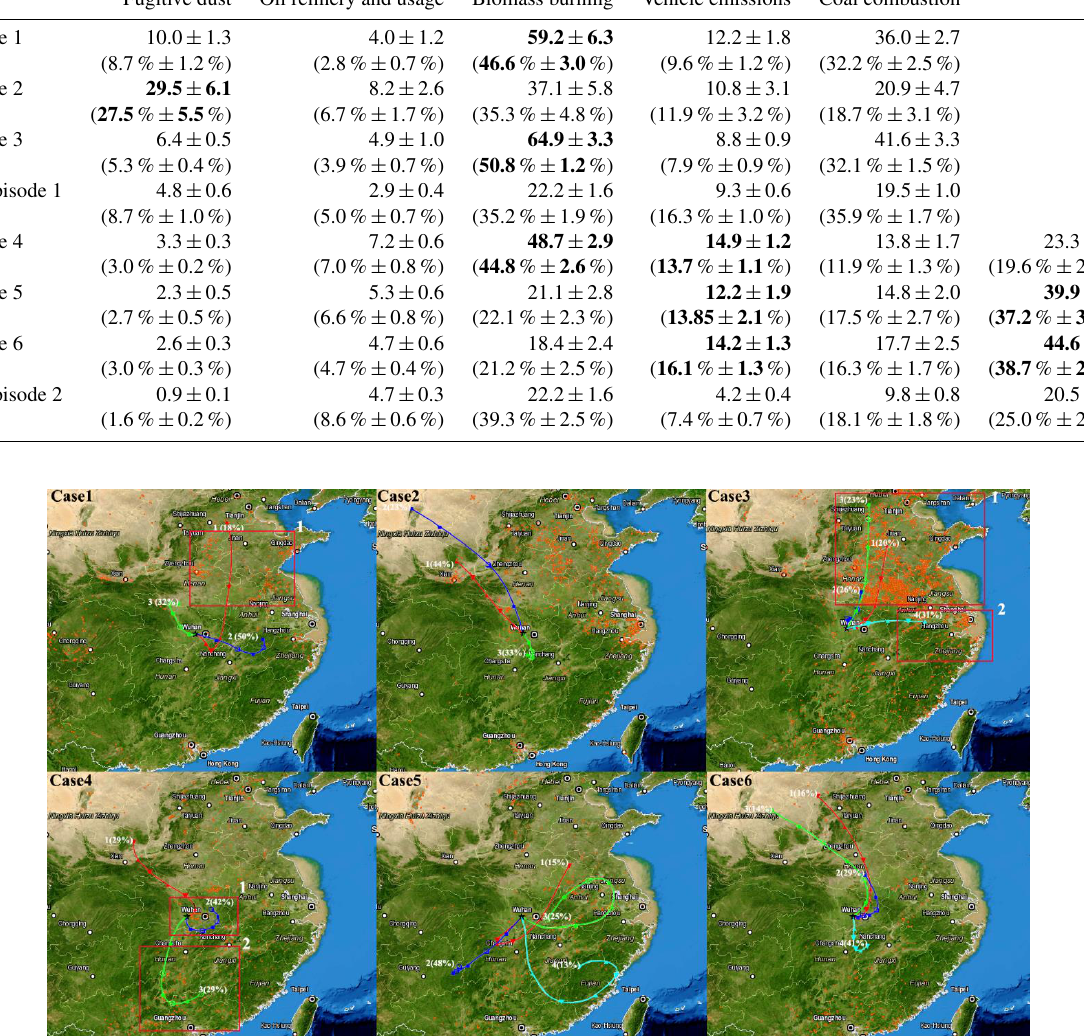
Figure 10. Wildfire distribution and 72h backward air mass trajectories. Red squares demonstrate potential areas where biomass burning aggravated particulate pollution in